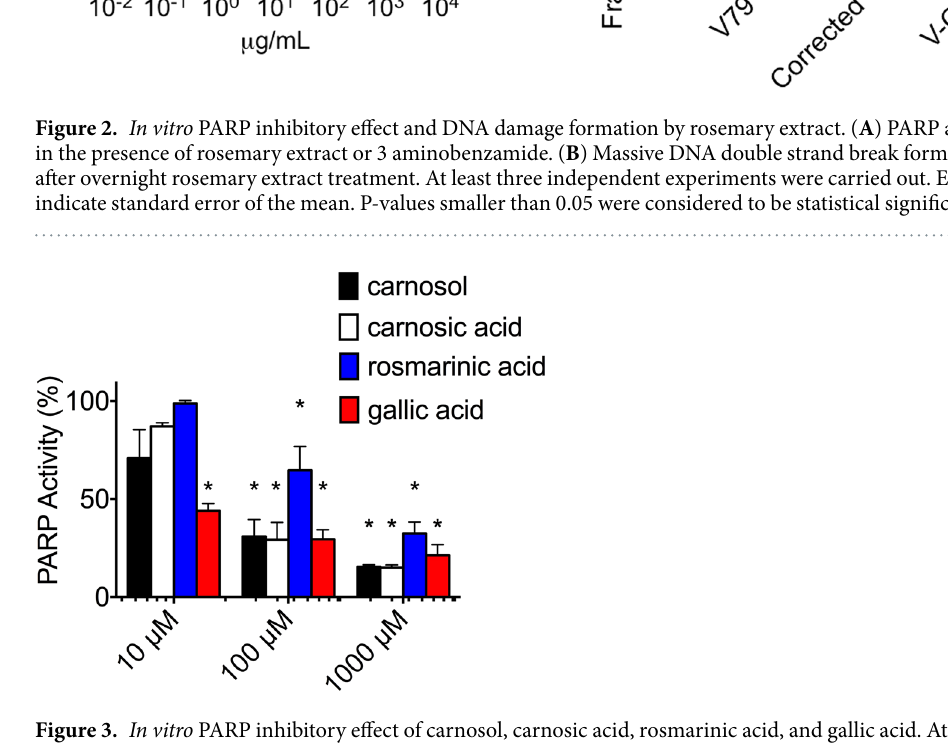
Figure 3. In vitro PARP inhibitory effect of carnosol, carnosic acid, rosmarinic acid, and gallic acid. At least three independent experiments were carried out. Error bars indicate standard error of the mean. * symbol indicates statistical significant reduction compared to control (P <